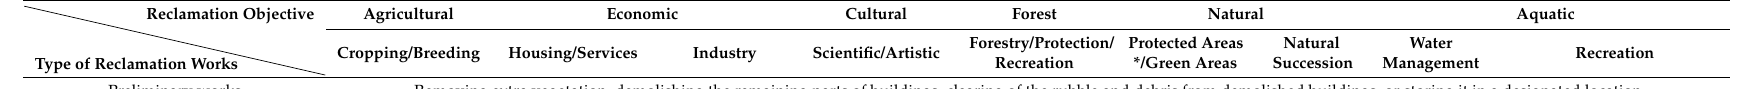
Table 2. The scope of reclamation works of the technical phase for areas after exploitation of clastic rocks and